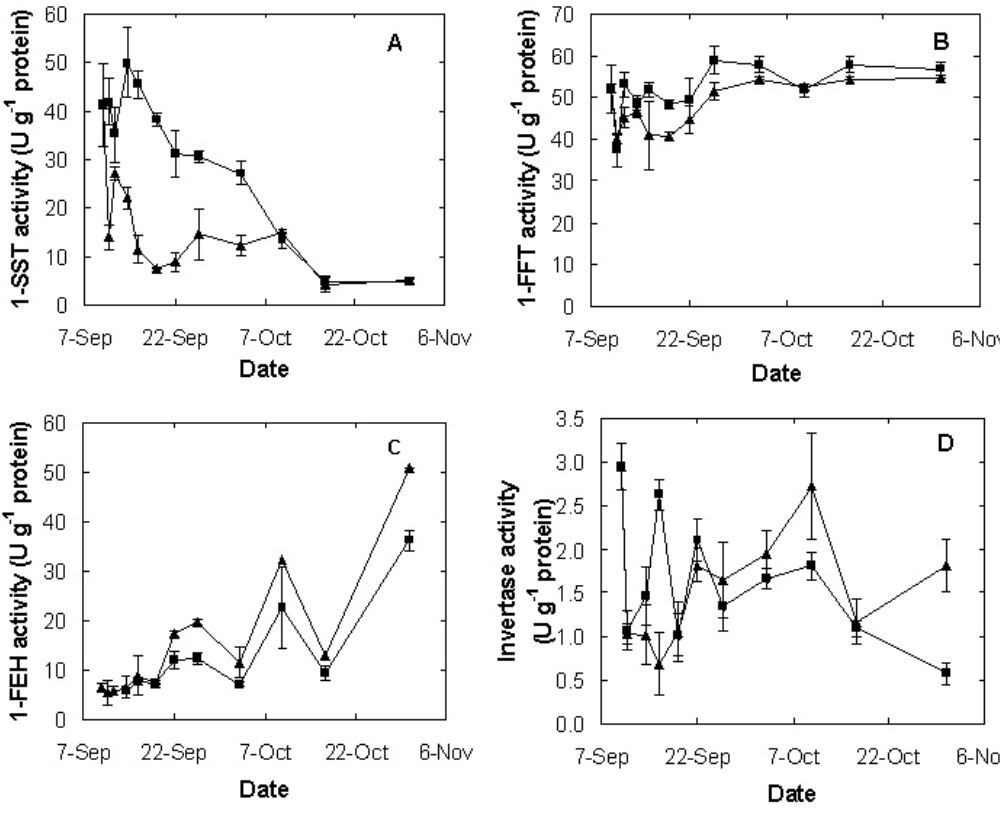
FIGURE 4 . Changes of the activities of 1-SST (A), 1-FFT (B), 1-FEH (C), and acid invertase (D) in the roots of intact ( ■ ) and defoliated ( ▲ ) field-grown chicory plants.